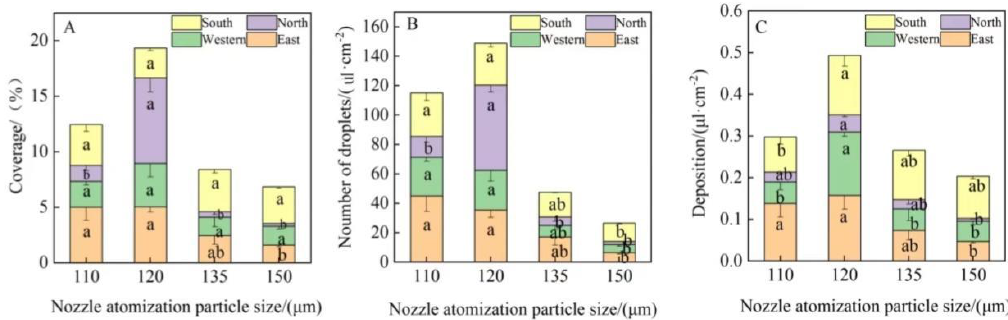
Figure 4. Comparison of atomizing particle sizes of different nozzles on the spray droplet effects in four directions of the ‘Kuerle Xiangli’ canopy: ( A ). comparison of atomizing particle sizes of different nozzles on the droplet coverage in four directions of the ‘Kuerle Xiangli’ canopy, ( B ). comparison of atomizing particle sizes of different nozzles on the droplet density in four directions of the ‘Kuerle Xiangli’ canopy, ( C ). comparison of atomizing particle sizes of different nozzles on the amount of droplet deposition in four directions of the ‘Kuerle Xiangli’ canopy. Different lowercase letters indicate significant difference in the same direction among different treatments ( p < 0.05 ).